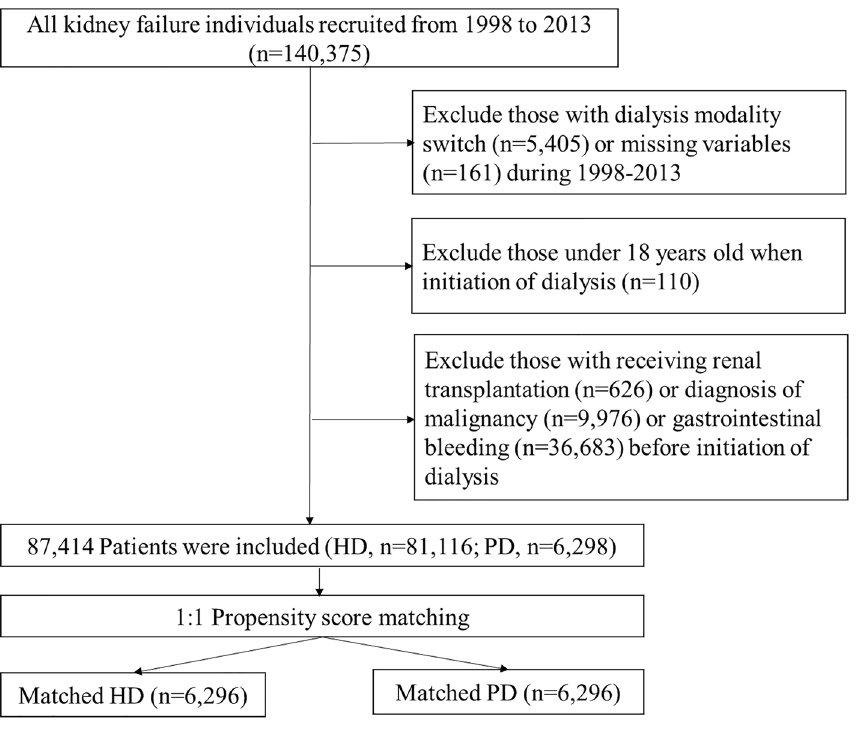
Figure 1. Flow chart of the establishment of matched pairs of patients receiving hemodialysis (HD) and peritoneal dialysis (PD) from the national cohort of kidney failure patients. Abbreviation: HD: hemodialysis, PD: peritoneal